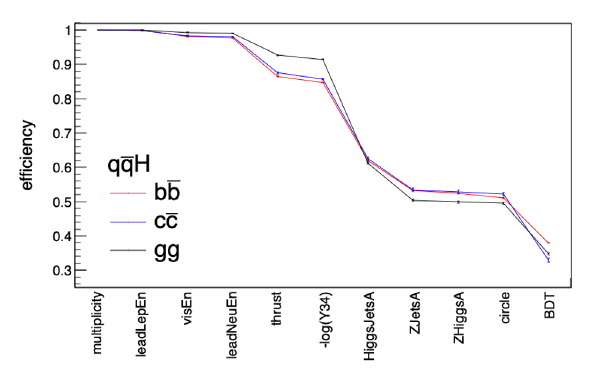
¯ b/c ¯ c/gg ) for each cut